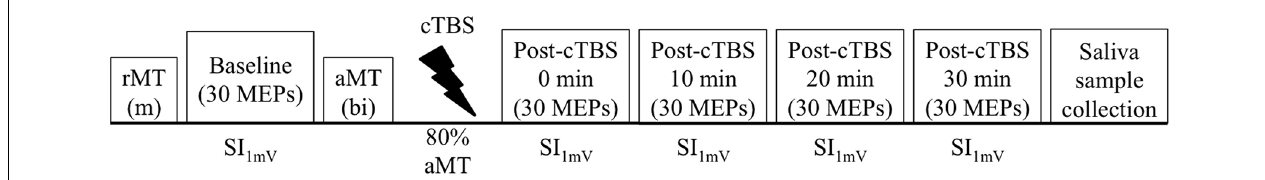
FIGURE 1 | Overview of experimental design. Thirty motor evoked potentials (MEPs) were collected before (Baseline), immediately after continuous theta-burst stimulation (cTBS) administration (Post-cTBS 0 min), and in 10 min intervals up to 30 min after administration of cTBS (Post-cTBS 10 min, Post-cTBS 20 min, and Post-cTBS 30 min). Stimulation intensity (SI) was individually adjusted to produce MEPs of approximately 1 mV (SI 1mV ), as determined prior to cTBS. Resting motor threshold (RMT) was determined using a monophasic (m) pulse waveform, whereas active motor threshold (aMT) was determined using a biphasic (bi) pulse